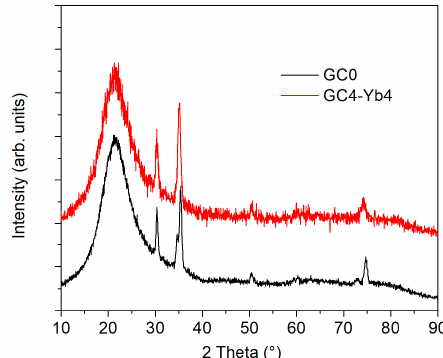
Figure 2. XRD comparison between silica-zirconia-soda GC samples with or without Yb co-doping. Undoped GC samples contain tetragonal-phase zirconia nanocrystals (PDF 01-080-0784; ICSD 68589), while Yb doped samples have a fluorite-type cubic-phase zirconia nanocrystals (PDF 01-078-1309; ICSD 62462), attested by the different shape of the characteristic reflection peaks, especially those at 2 θ ≈ 35.5° and 2 θ ≈ 75°.